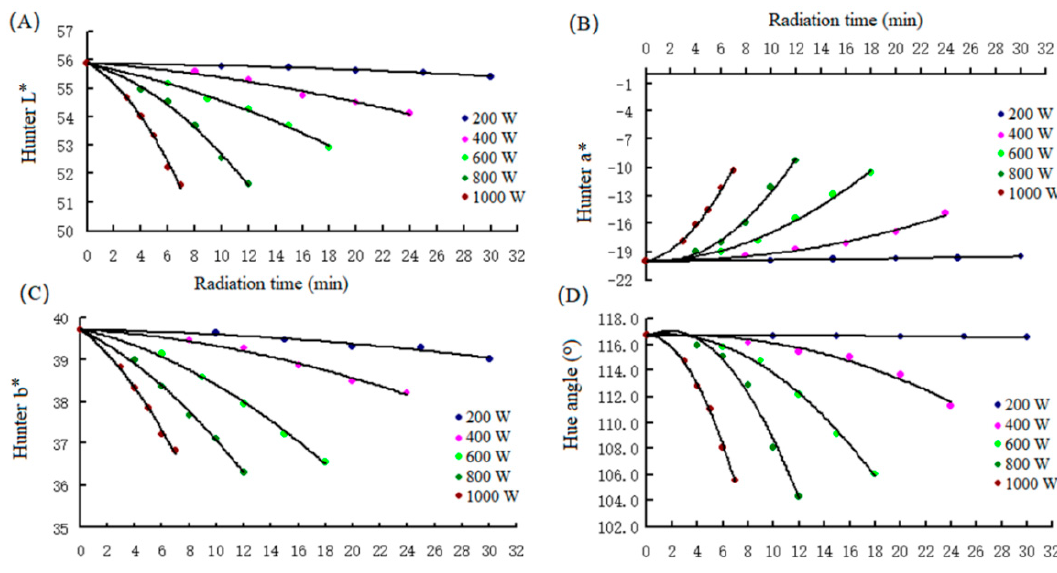
Figure 1. L* ( A ), a* ( B ), b* ( C ), and H a ( D ) values of green tea powder samples at different microwave power with various radiation times. All the determination values from the three experiments gave an RSD of 0.4 −